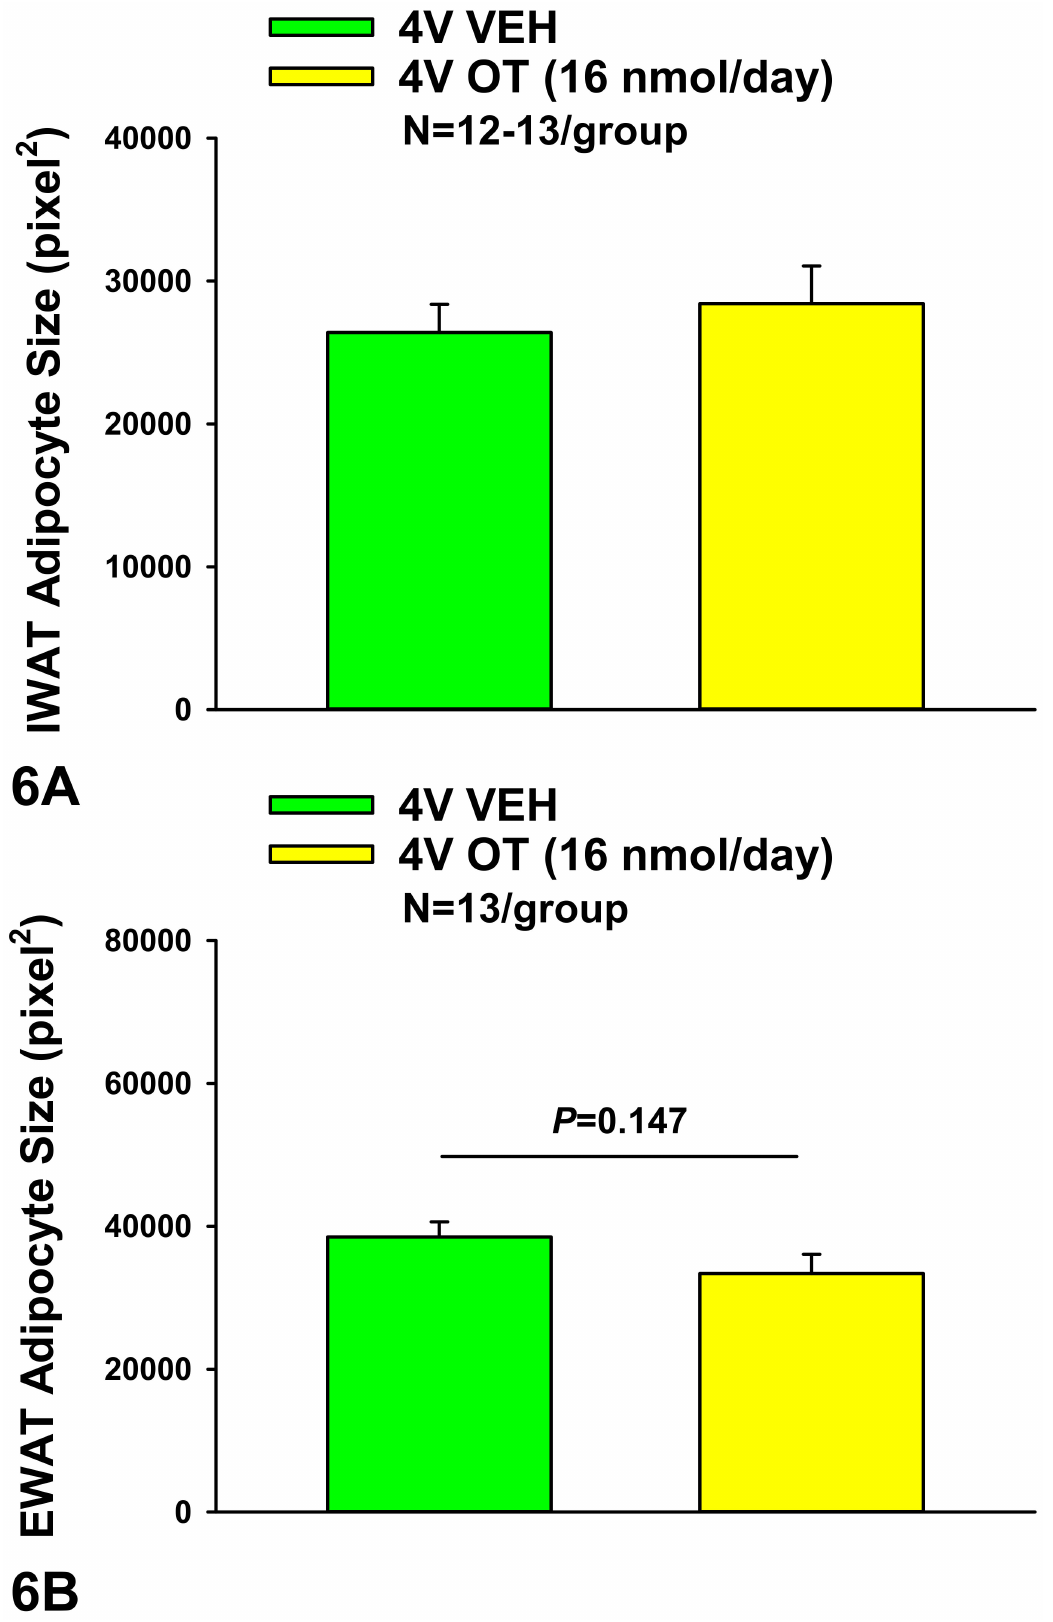
Figure 6. ( A , B ): Effect of chronic 4V OT infusions (16 nmol/day) on adipocyte size in IWAT and EWAT in male HFD-fed CD ® IGS rats. Adipocyte size (pixel 2 ) was measured in ( A ), IWAT and ( B ), EWAT from rats that received chronic 4V infusion of vehicle or OT (16 nmol/day) (N = 13/group). Data are expressed as mean ±